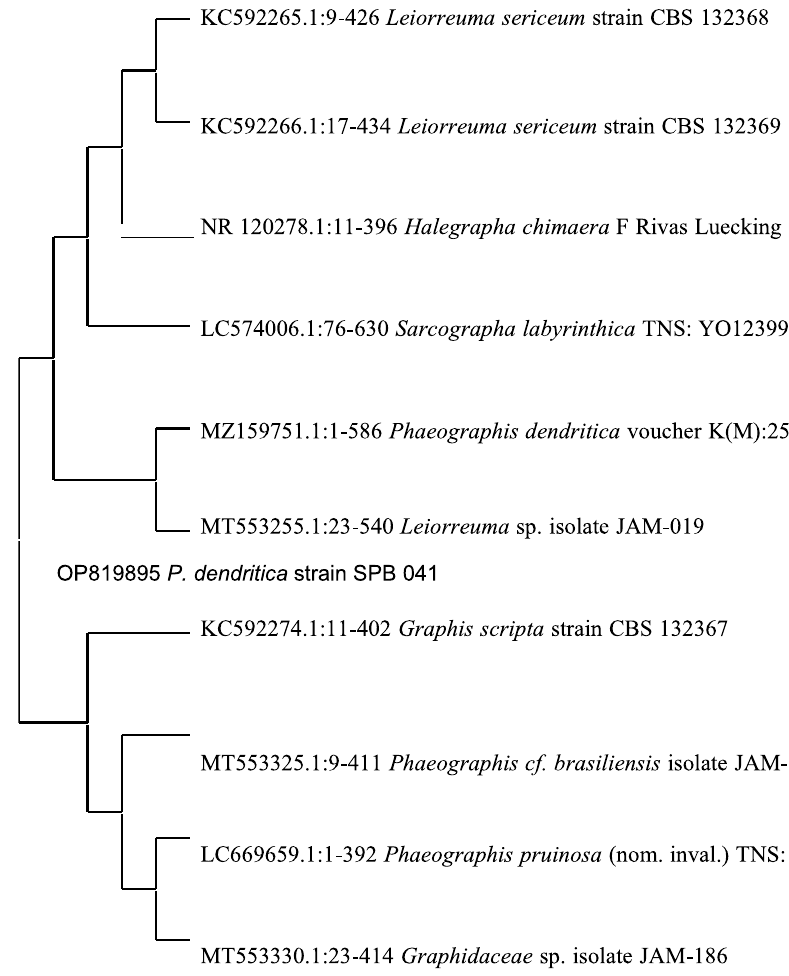
Fig. 5 Phylogenetic relationship of T. virens across neighbor‑joining